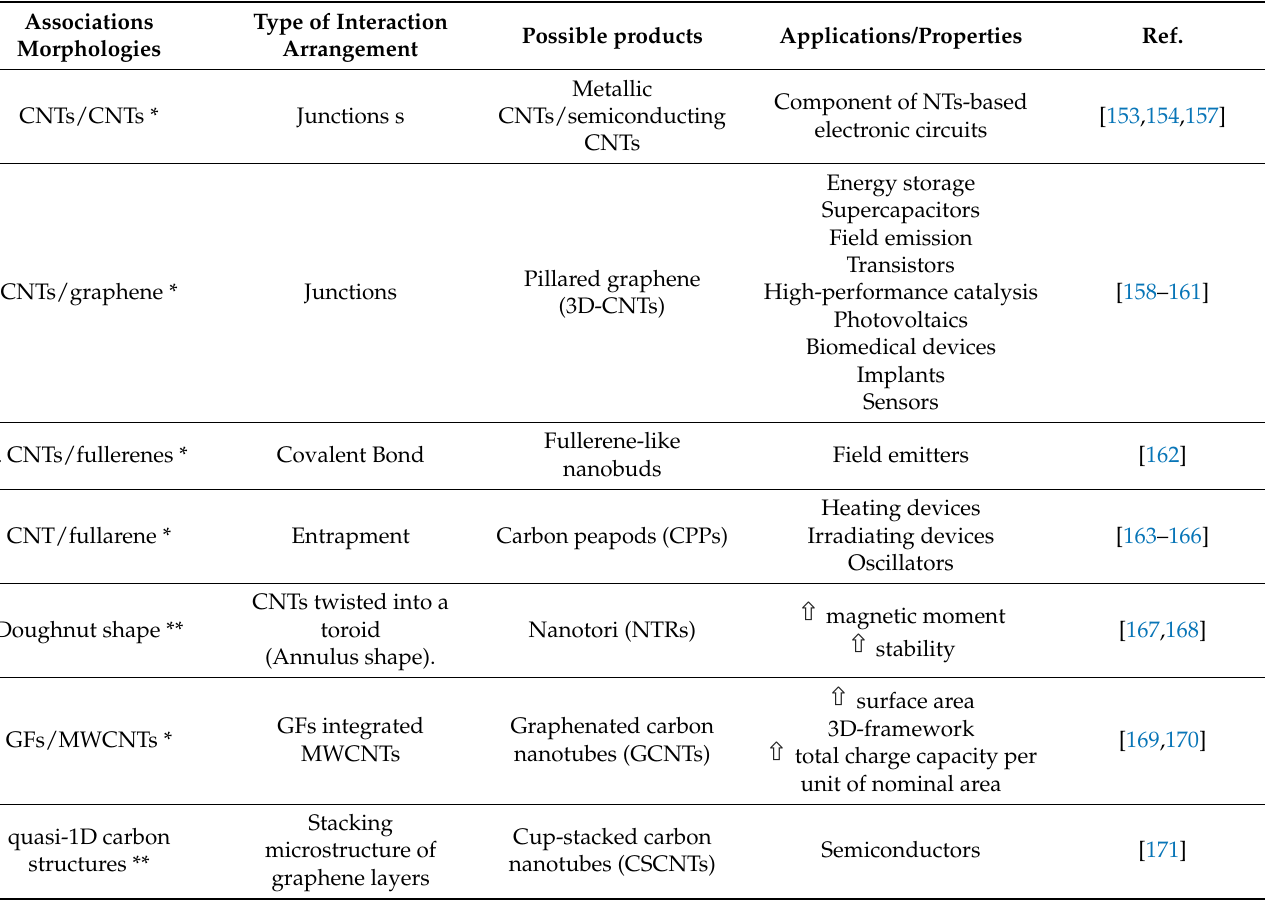
Table 8. Possible Associations between the different known allotropes of carbon and particular morphologies of CNTs.